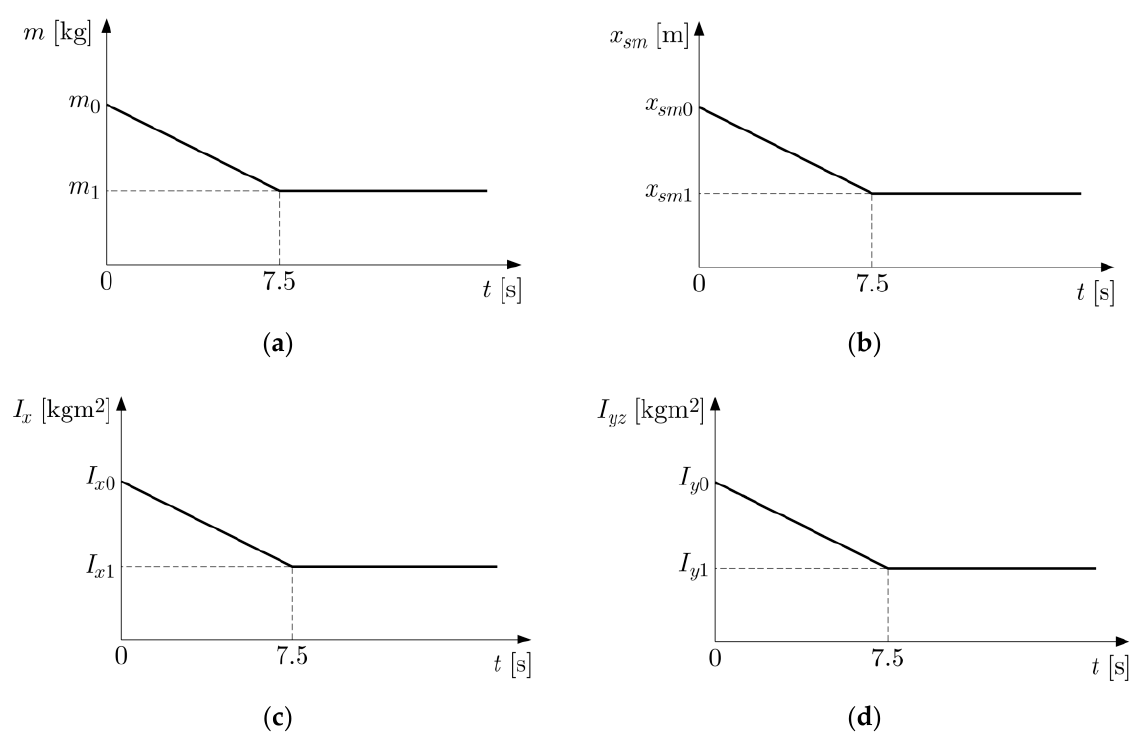
Figure 3. ( a ) Graph of mass change; ( b ) graph of the center of mass change; ( c , d ) graph of moments of inertia change.